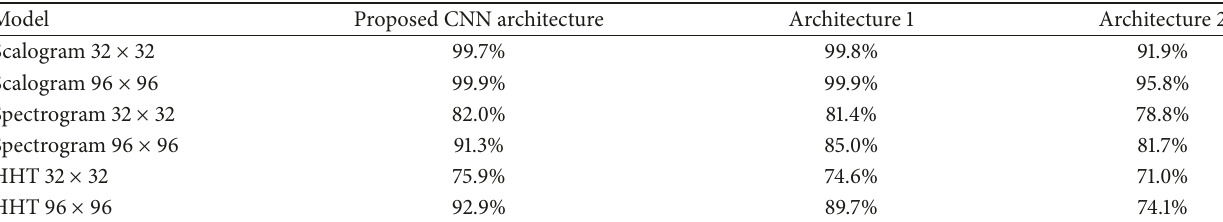
Table 10: Precision for MFPT data set.